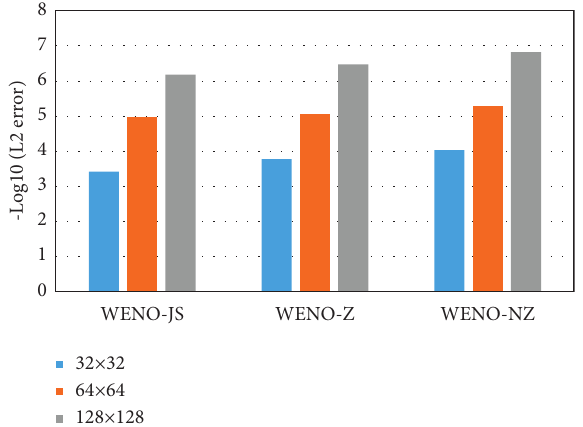
Figure 5: Bar graph of L error orders for densities about WENO- 2 JS, WENO-Z, and WENO-NZ